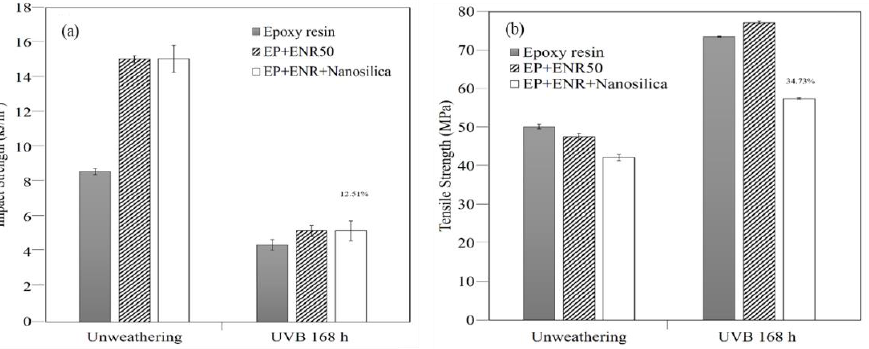
Figure 6. The mechanical properties of nanocomposites after UVB exposure for accelerated aging: ( a ) impact strength and ( b ) tensile ( a ) impact strength and ( b ) tensile strength.